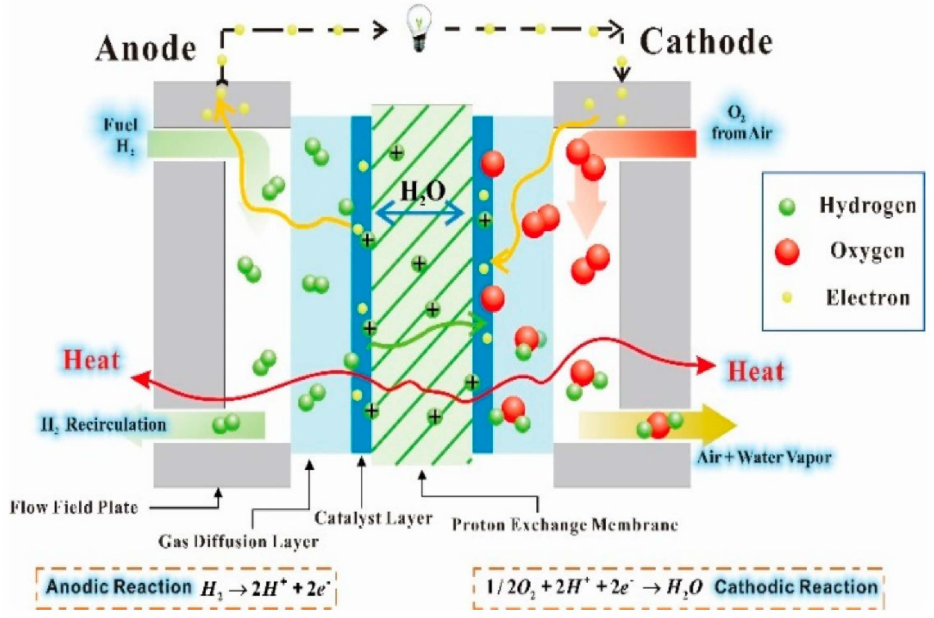
Figure 6. Schematic of a PEMFC [92]. Copyright ©2019 ChemEngineering. The three-phase boundaries (TPBs) are located in the porous structure of CL. The for- mation of the porous structure is mainly due to the interaction of dispersed solvent, ionomer and catalyst particles during evaporation. Therefore, the formation of three-phase bound- ary is closely related to the type, properties and quantity of solvent in the slurry, material properties of catalyst and ionomer, dispersion method of slurry, coating and drying process. It is a multi-factor coupling process from dynamic to static. Due to it being difficult to control the slurry preparation, dispersion, coating and drying process of the CL accurately, the pore structure in CL is random and disordered, and some catalysts and ionomers cannot reach the conditions of three-phase reaction active sites, that is, these catalysts and ionomers will inevitably be wasted, leading to a significant reduction in catalyst utilization rate. Here are some common